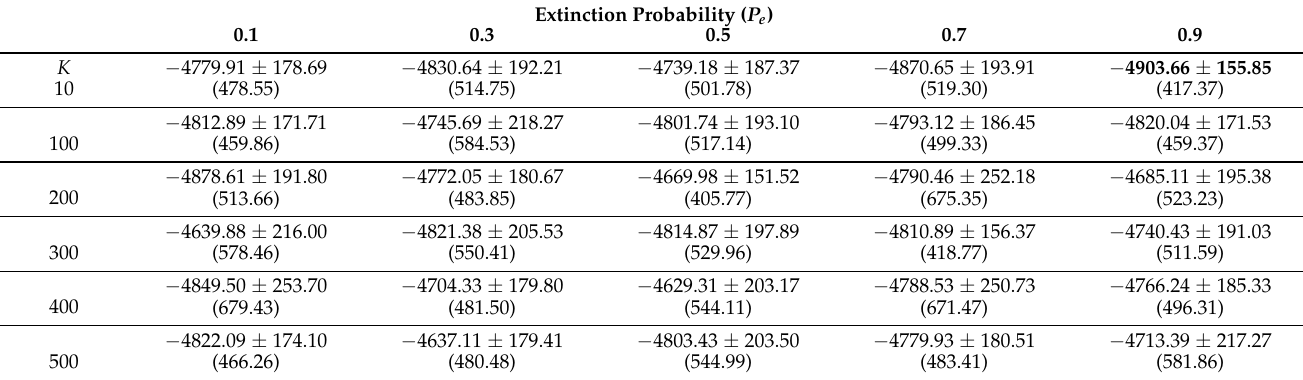
Table 4. Fitness results of SDEP with random extinction on Schwefel ( K is the stagnant counter); 95% confidence interval is presented after ± sign, and standard deviation is presented inside parenthesis. Minimum results are in bold font.